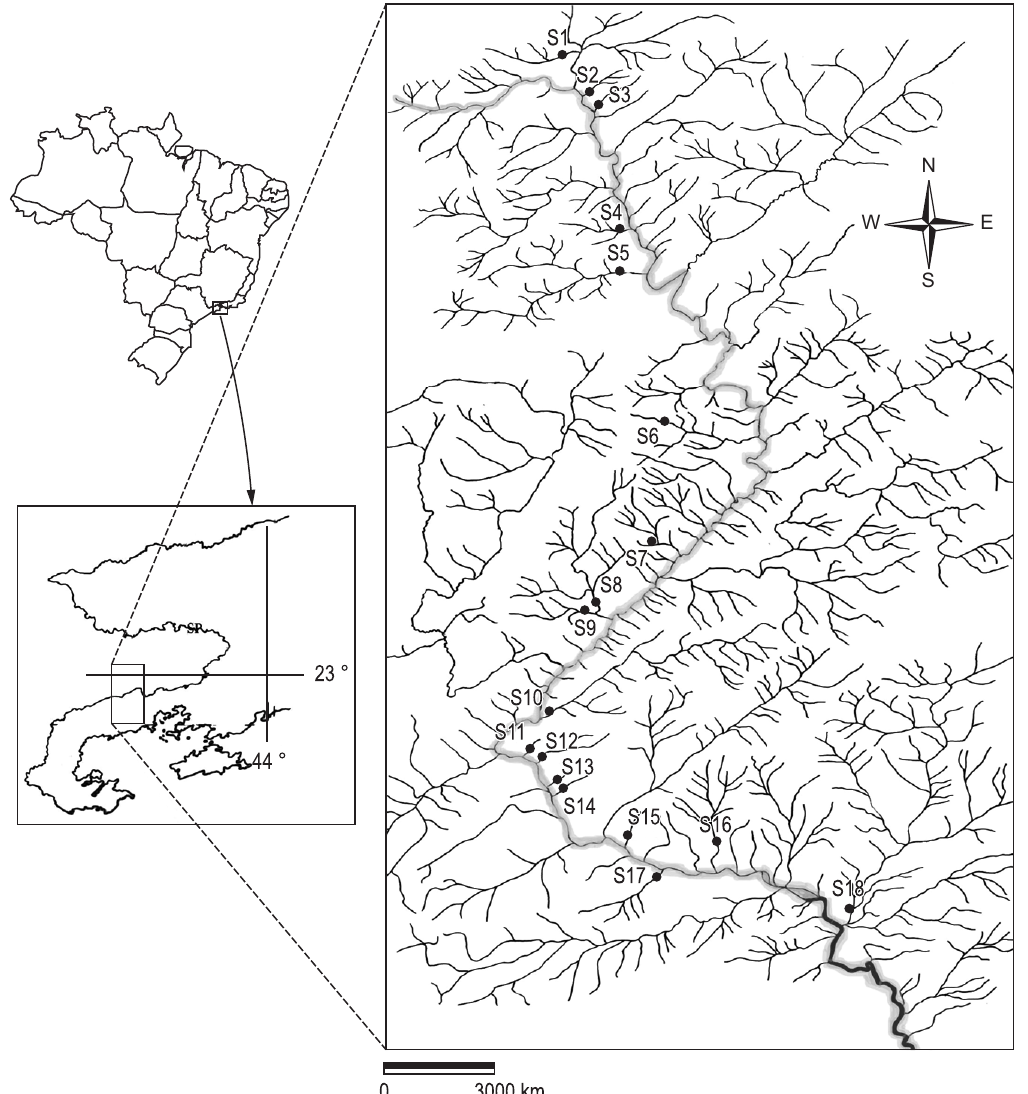
Figure 1. Map of Mambucaba River basin, showing the eighteen (  ) sampling sites. Mambucaba River is marked